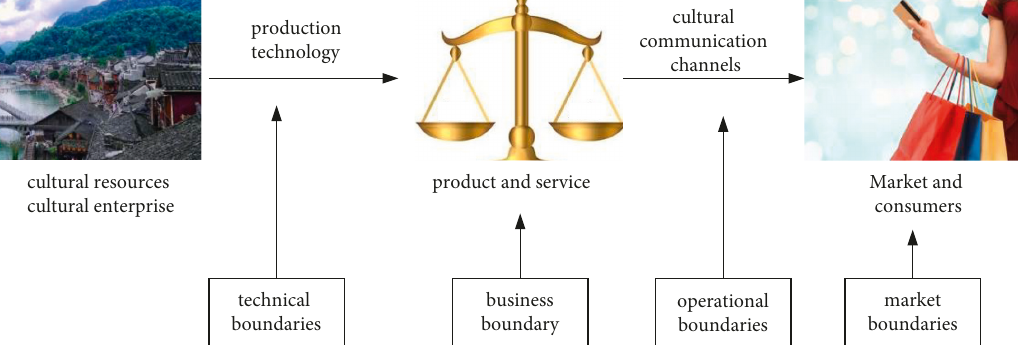
Figure 1: Industrial boundaries of cultural industries.